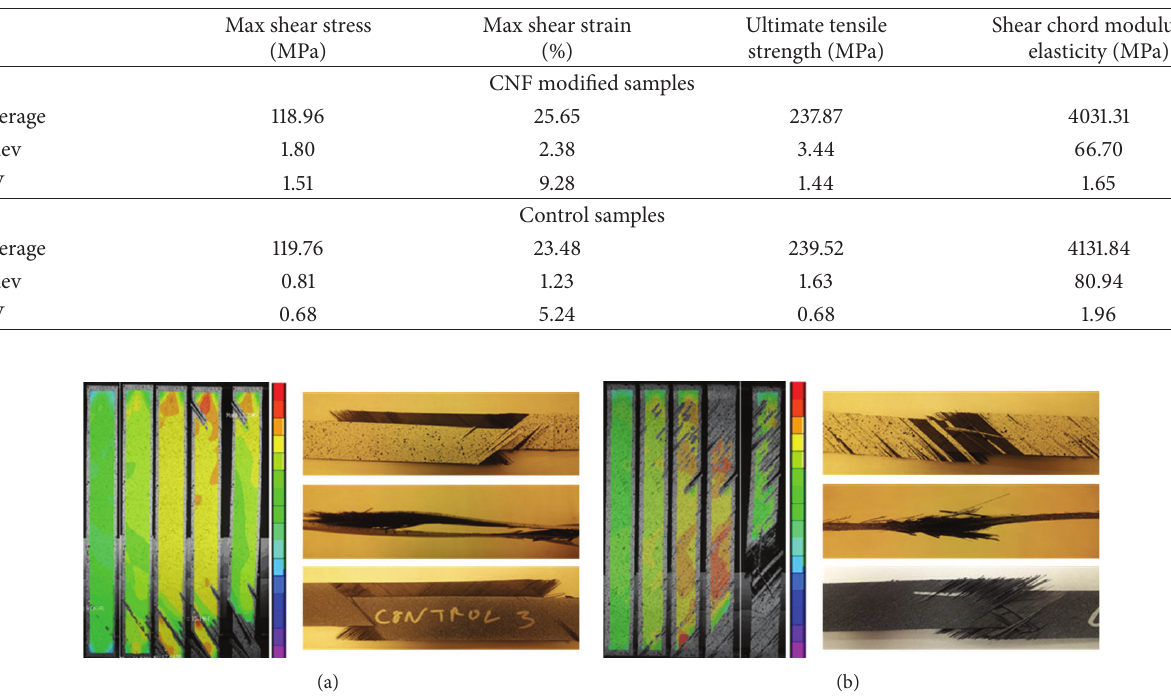
Figure 5: DIC images for a representative control sample (a) and for a representative CNF modified sample (b). The screen shots represent the samples as they begin to experience the color coordinated strain levels. The colors as described by the color bars to the right of the images represent strain concentrations on the front of the samples. The pictures of the fractured samples are also shown in the front-view, side-view, and back-view to be compared with the DIC